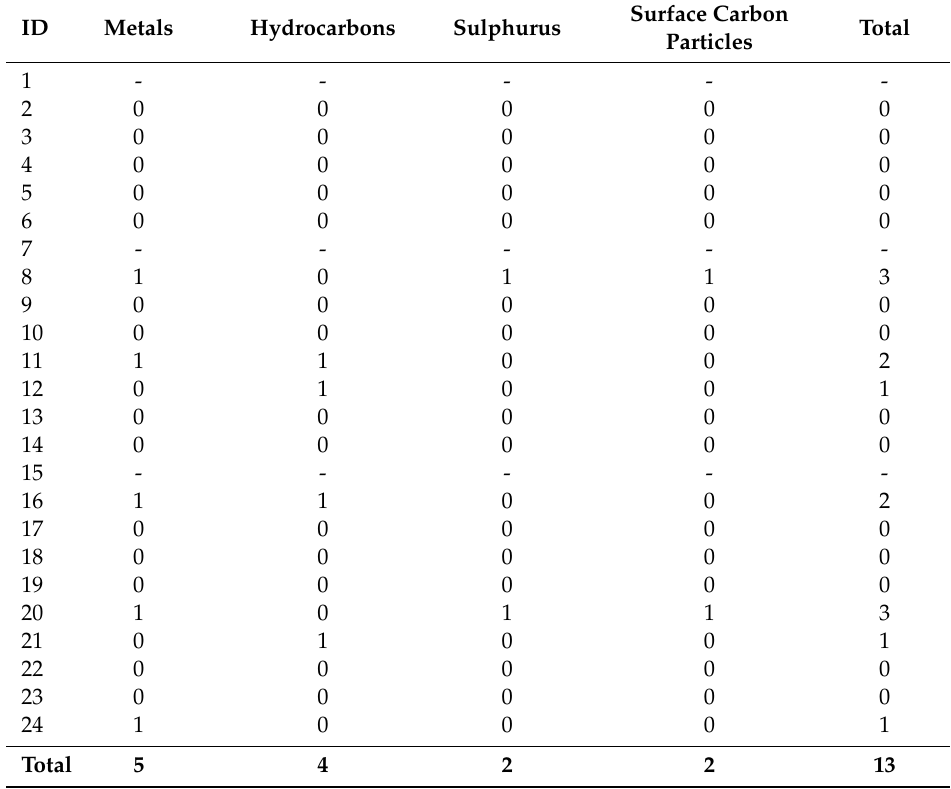
Table A4. Irrelevant descriptors identified in the sediment